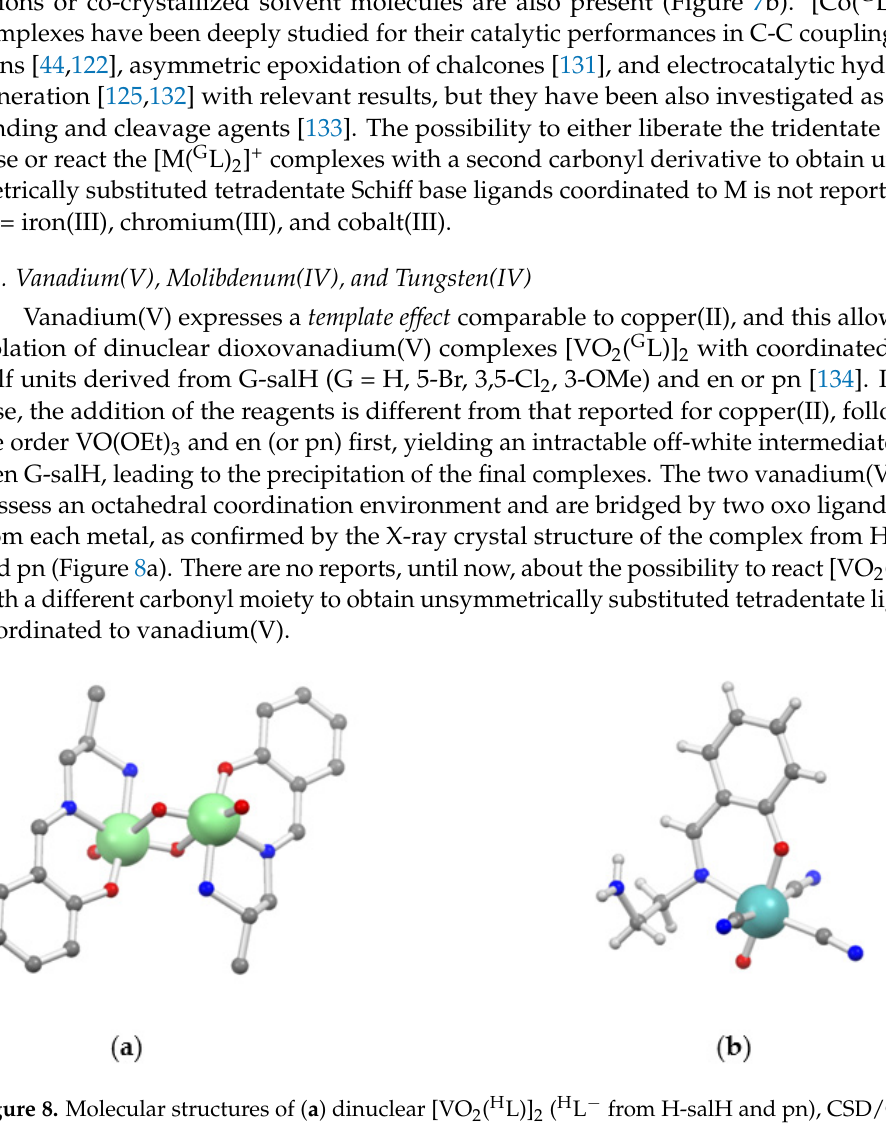
Figure 8. Molecular structures of ( a ) dinuclear [VO 2 ( H L)] 2 ( H L − from H-salH and pn), CSD/CCDC HAKROA/1171813 [134], and ( b ) [PPh 4 ] 2 [Mo(CN) 3 O( H L)] · 5.5H 2 O ( H L − from H-salH and en), CSD/CCDC HEZZUH/113815 [135]. Reproduction of the structures with Mercury ® 4.3.1 soft- ware [71], color code: Mo = turquoise, V = light green, O = red, N = blue, C = gray, H = white or omitted, PPh 4+ cations and water molecules omitted for